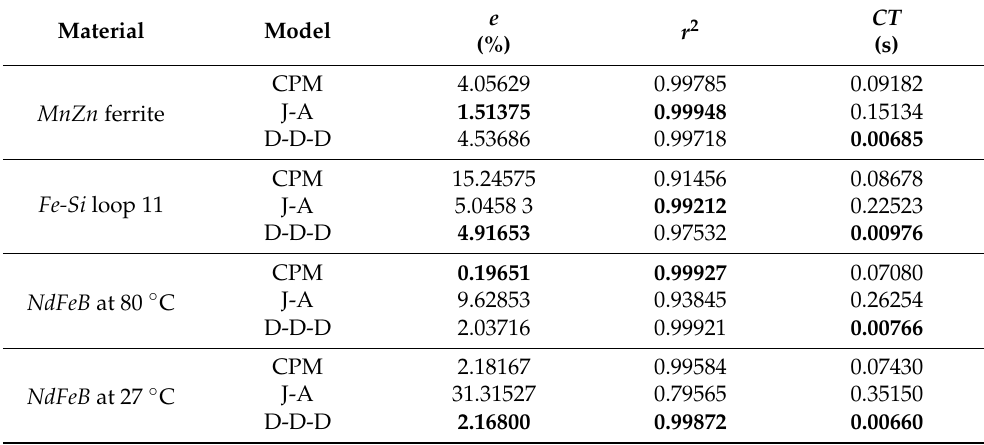
Table 2. Numerical comparison of the considered models. Bolded values are the most performant